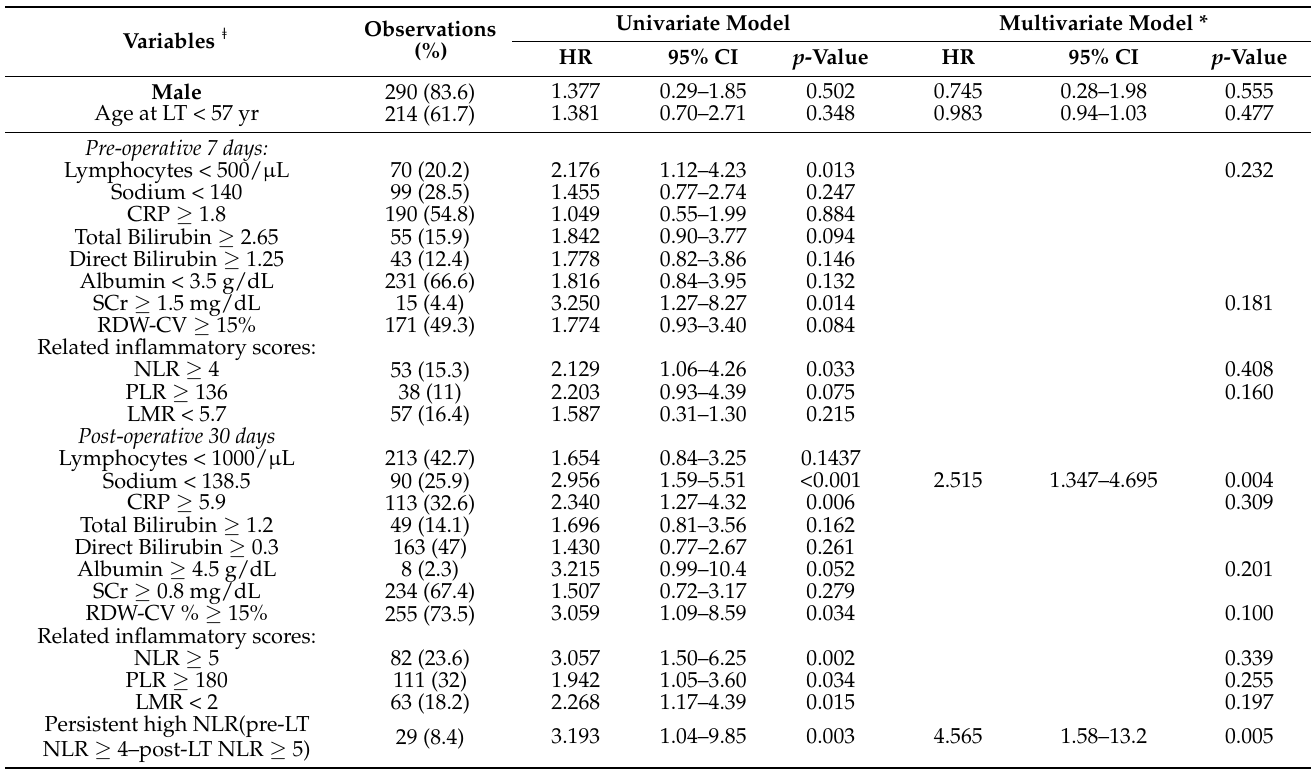
Table 1. Laboratory results and associations with all-cause mortality in the study